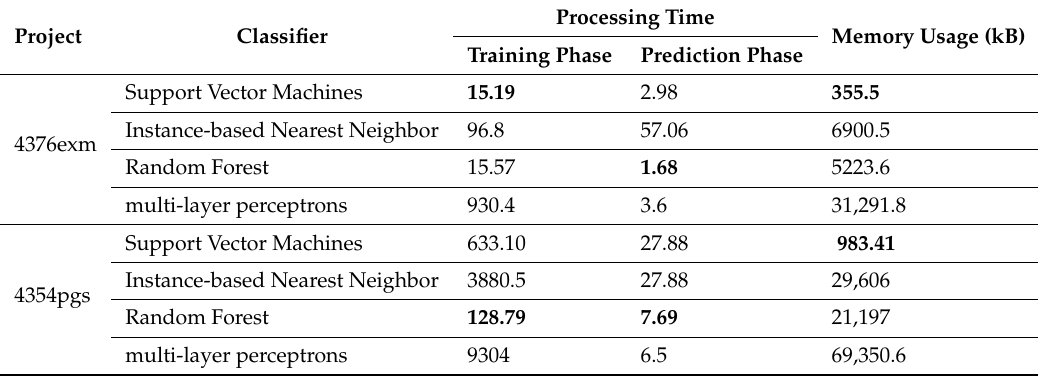
Table 3. Processing time and memory usage of different classification strategies of two projects (4354pgs and 4376exm).